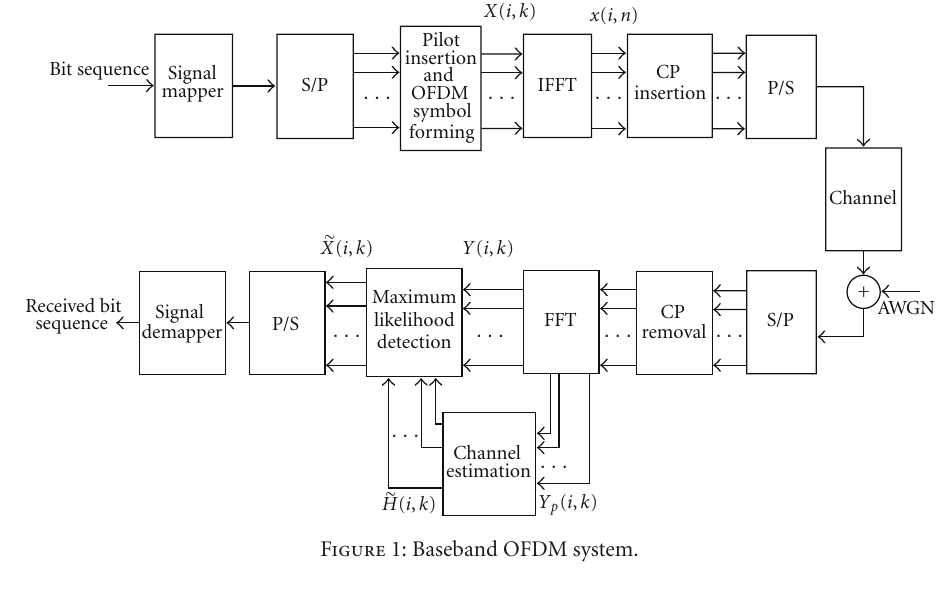
Figure 1: Baseband OFDM system.